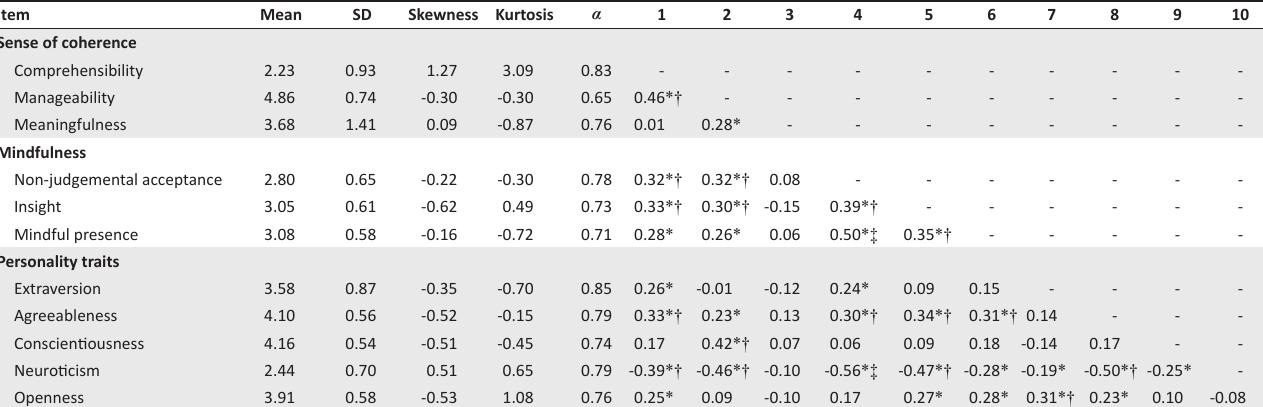
TABLE 2: Descriptive statistics, reliabilities and correlations between sense of coherence, mindfulness and Big 5 personality traits. Item Mean